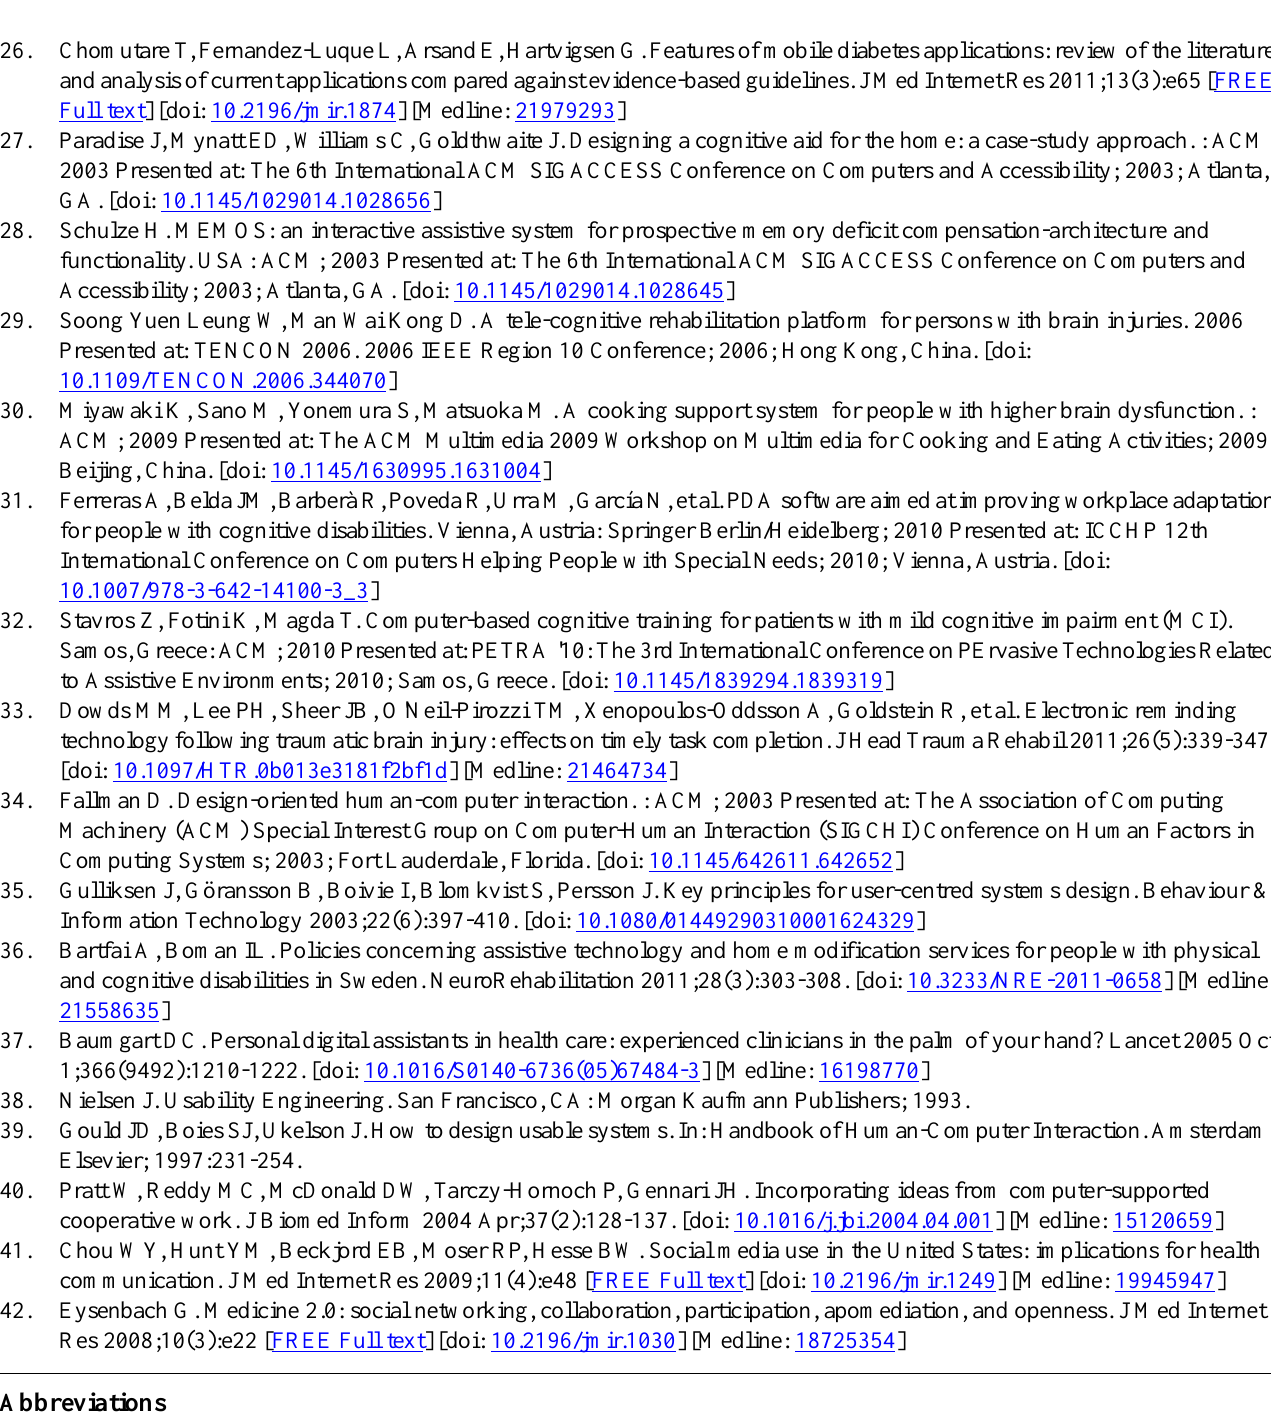
Abbreviations ICF: International Classification of Functioning, Disability and Health ICT: information and communication technology MACI: mild acquired cognitive impairment MCI: mild cognitive impairment TBI: traumatic brain